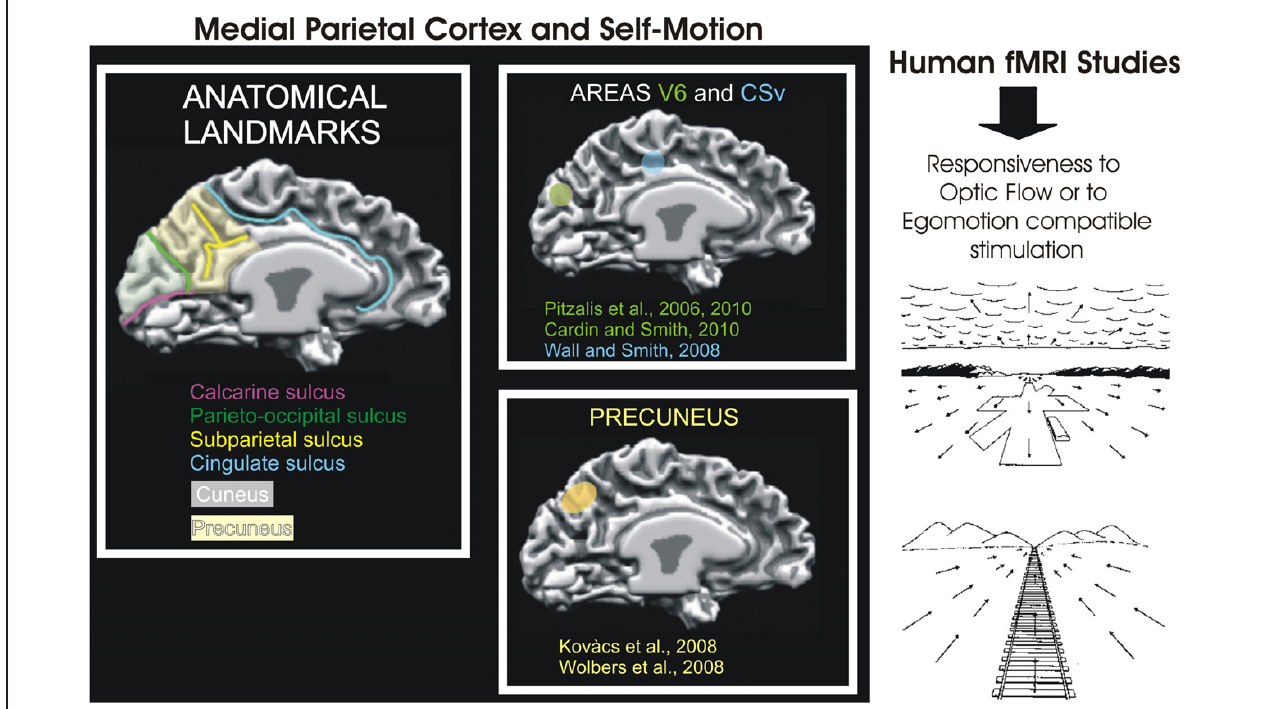
2010; Pitzalis et al., 2010); CSv (light blu) (Wall and Smith, 2008) and Precuneus (yellow) (Kovács et al., 2008; Wolbers et al., 2008). Modified from Culham et al., 2008. Right : Examples of retinal optic flow. Expanding optic flow during forward motion. Panel shows a typical retinal optic flow during a landing. The landing field, the mountains and the clouds are visible. Contracting optic flow during inward motion. Panel shows a typical retinal optic flow seen by an observer sitting on a moving train and looking in the opposite direction respect to the motion direction of the train. In both panels, the arrows indicate the optic flow direction. The arrows length is proportional to the speed of motion. Modified from Bruce et al. (1996).